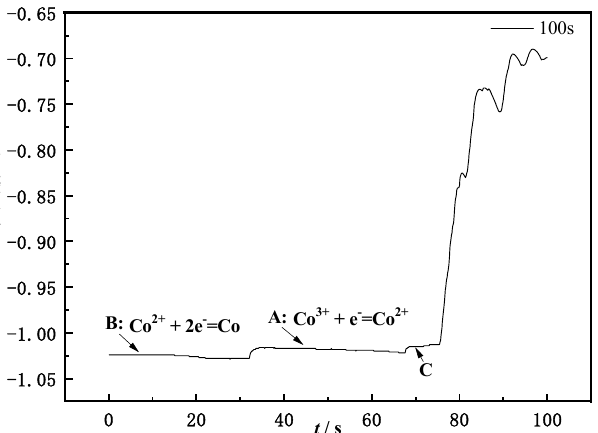
Figure 5. Open circuit chronopotential of NaCl-CaCl 2 -LiCoO 2 molten salt system (100 s; Fe elec-